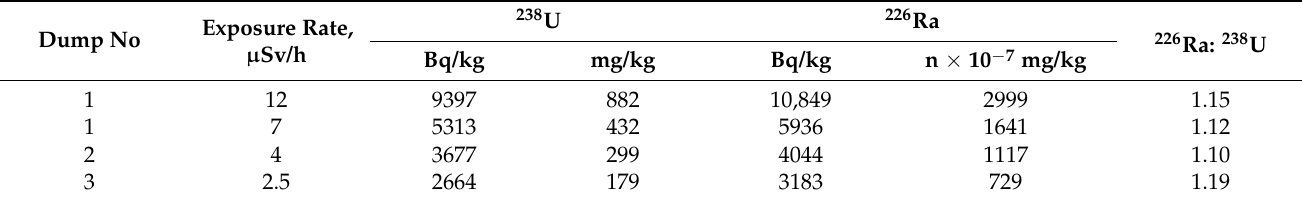
Table 2. Content of 238 U and 226 Ra in the fine earth fraction of the dumps of the Kurung site. Exposure Dump No